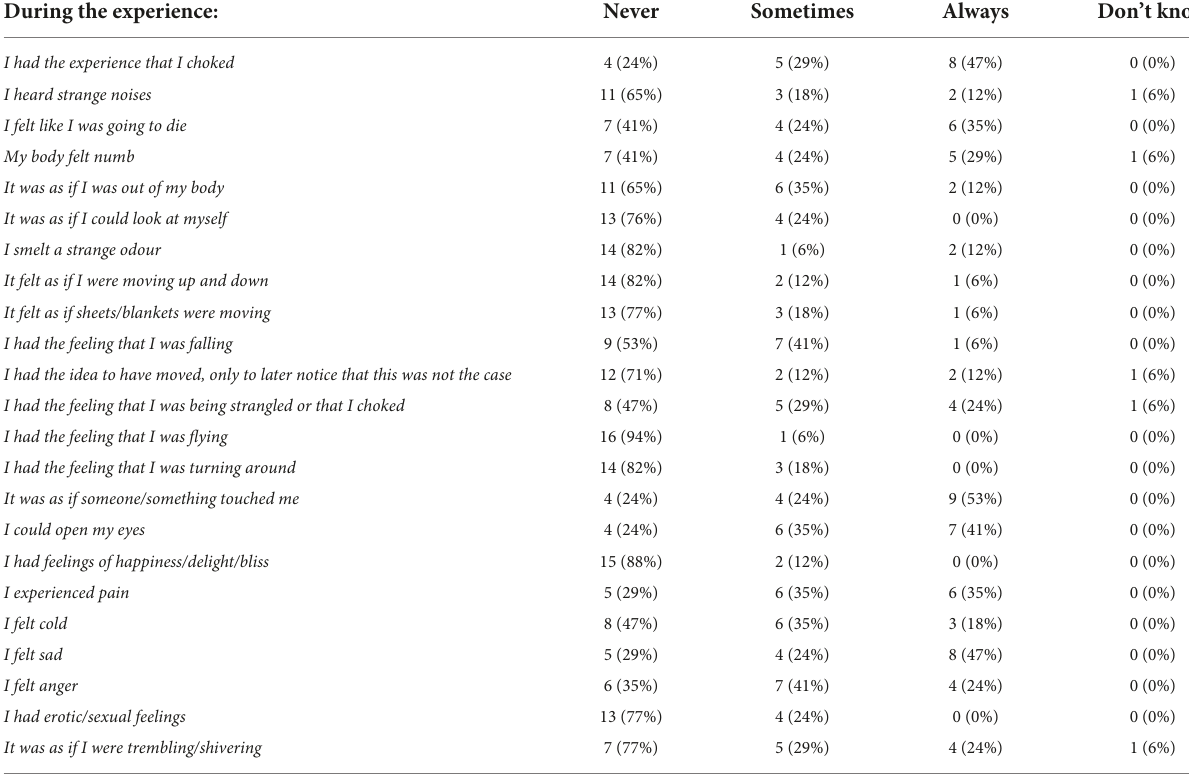
TABLE 2 Verbatim emotional reactions to the incubus phenomenon in the patient group ( n = 17). During the experience: Never Sometimes